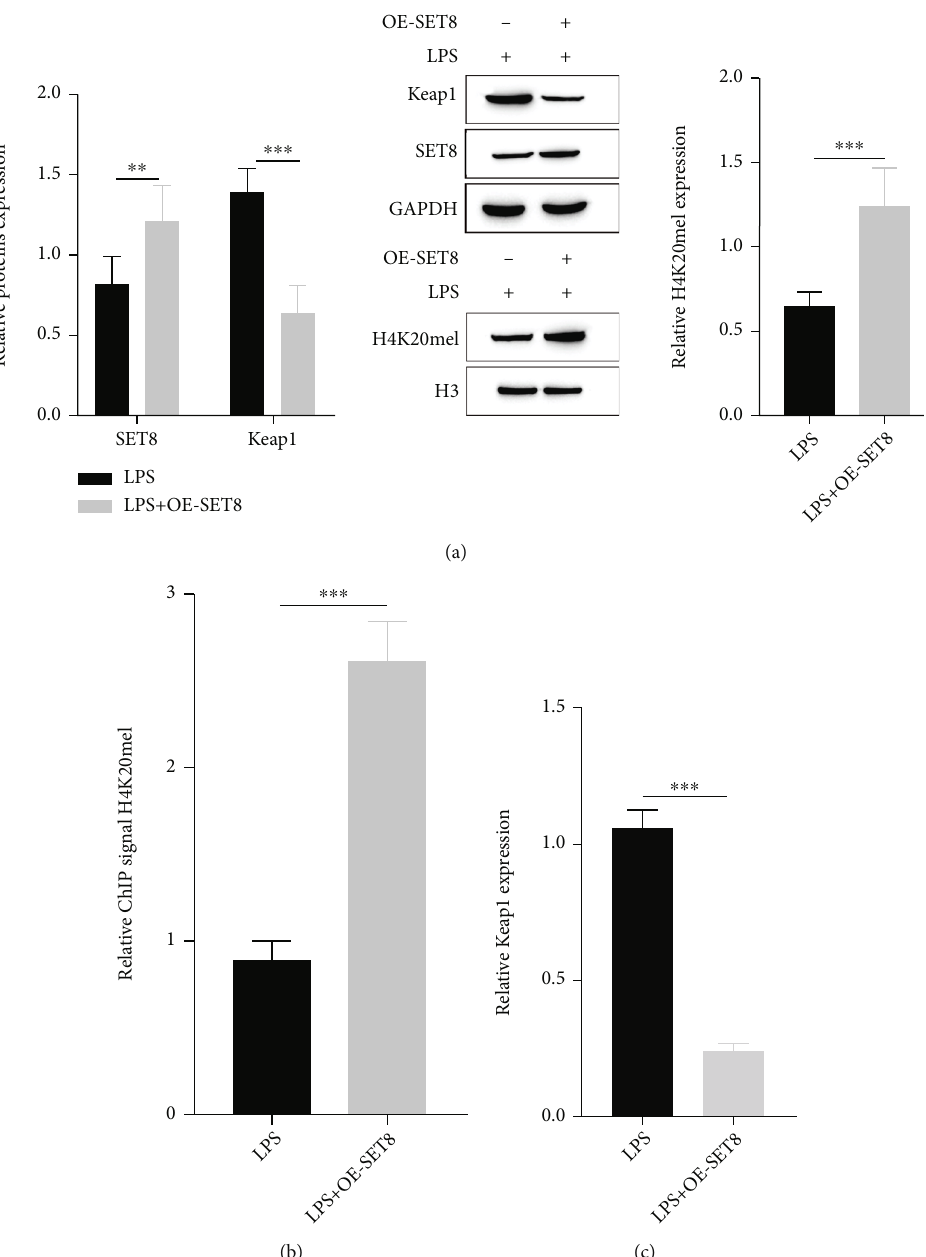
Figure 3: SET8 reduces Keap1 expression by enhancing H4K20me1 enrichment in the Keap1 promoter region. (a) Western blotting analysis of Keap1 and H4K20me1 expression under di ff erent conditions of NC+LPS and NC+LPS+OE-SET8; (b) ChIP detection of H4K20me1 enrichment in the Keap1 promoter region; (c) RT – qPCR analysis of Keap1 mRNA expression under di ff erent conditions of NC+LPS and NC+LPS+OE-SET8 expression under di ff erent